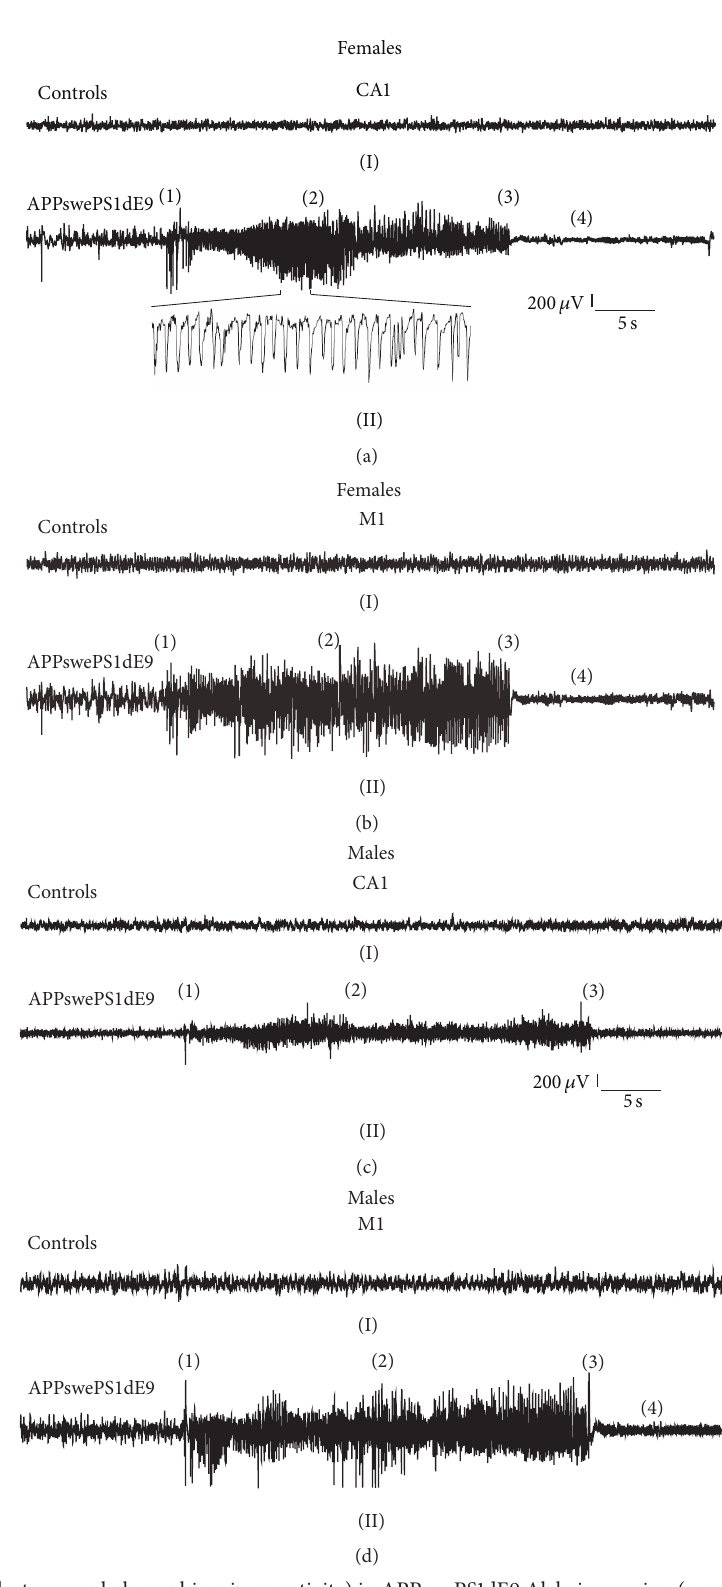
Figure 1: Ictal discharges (electroencephalographic seizure activity) in APPswePS1dE9 Alzheimer mice. (a and b) Representative 1 min EEG traces recorded from female controls (I) and APPswePS1dE9 mice (II) using a deep, intracerebral CA1 deflection (a) and an epidural surface electrode on the primary motor cortex (M1, b). Note that Alzheimer mice (II) display spike/spike train episodes which are characterized by spiking initiation (1), continuation (2), and termination (3). Reduced EEG amplitude following seizure termination represents postictal depression (4). Electroencephalographic seizure activity is present in both cortical and intrahippocampal recordings. (c and d) Representative 1min EEG traces from male controls (I) and Alzheimer mice (II) obtained from CA1 (c) and M1 (d) deflections. As for females, spike/spike- wave train episodes are prominent in APPswePS1dE9 animals (time bar, 5 s; voltage bar, 200 𝜇